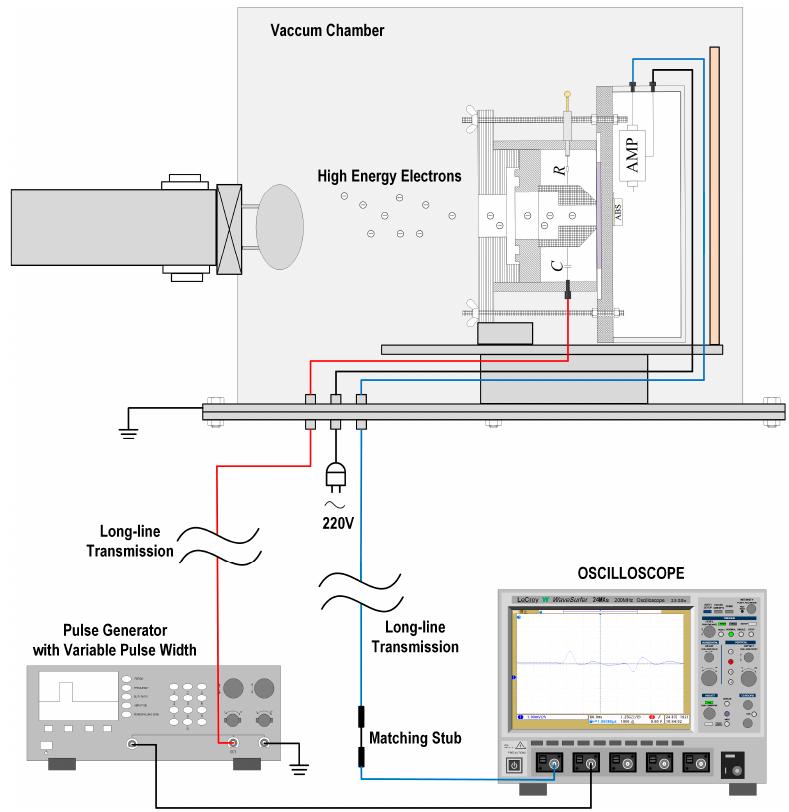
Figure 2. In-situ measurement system of space charge distribution under high-energy electron radiation.